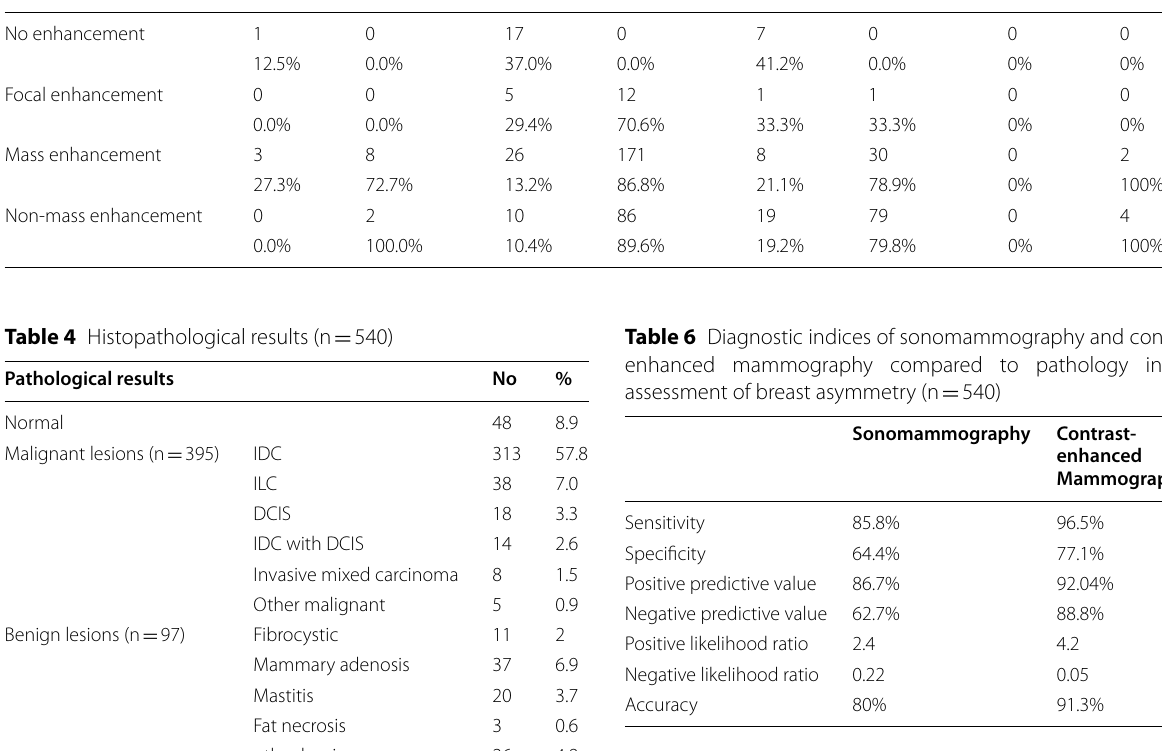
Table 5 Histopathology of CEM false-positive cases (N